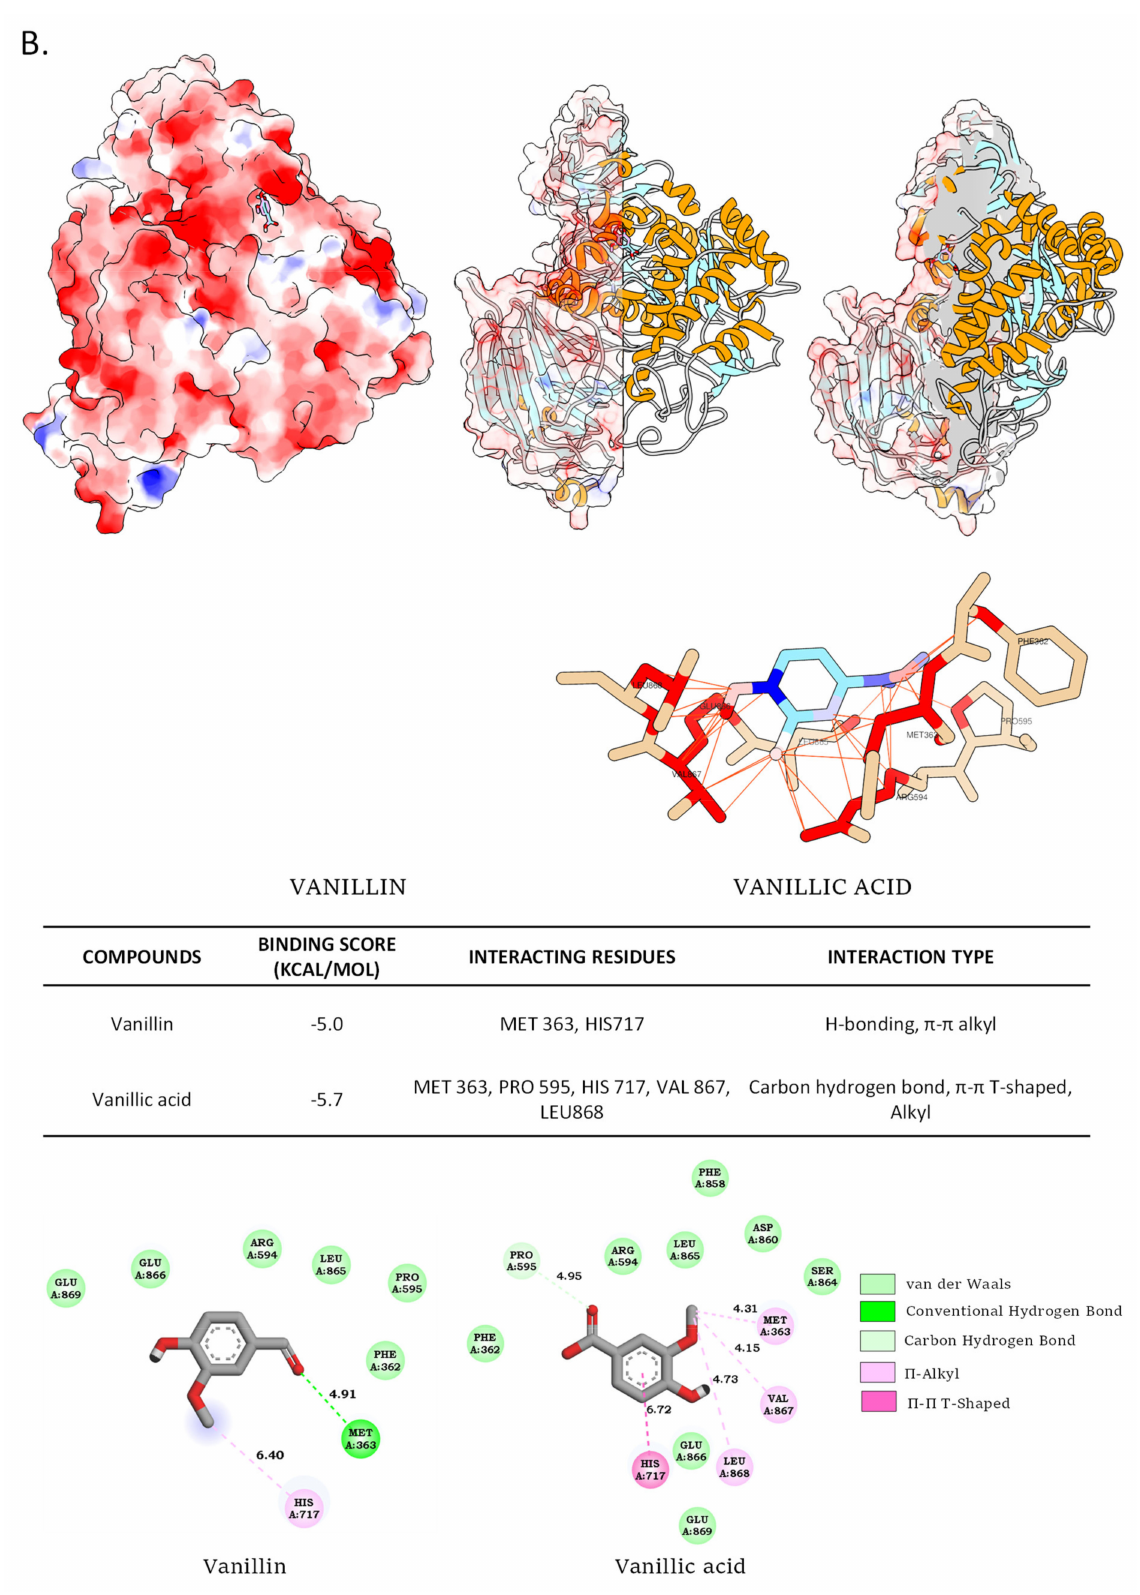
Figure 8. Molecular docking simulations of binding and interaction mode of ( A ). ( − )-catechin and ellagic acid to the intestinal α -amylase, and ( B ). vanillic acid and vanillin to the human pancreatic α